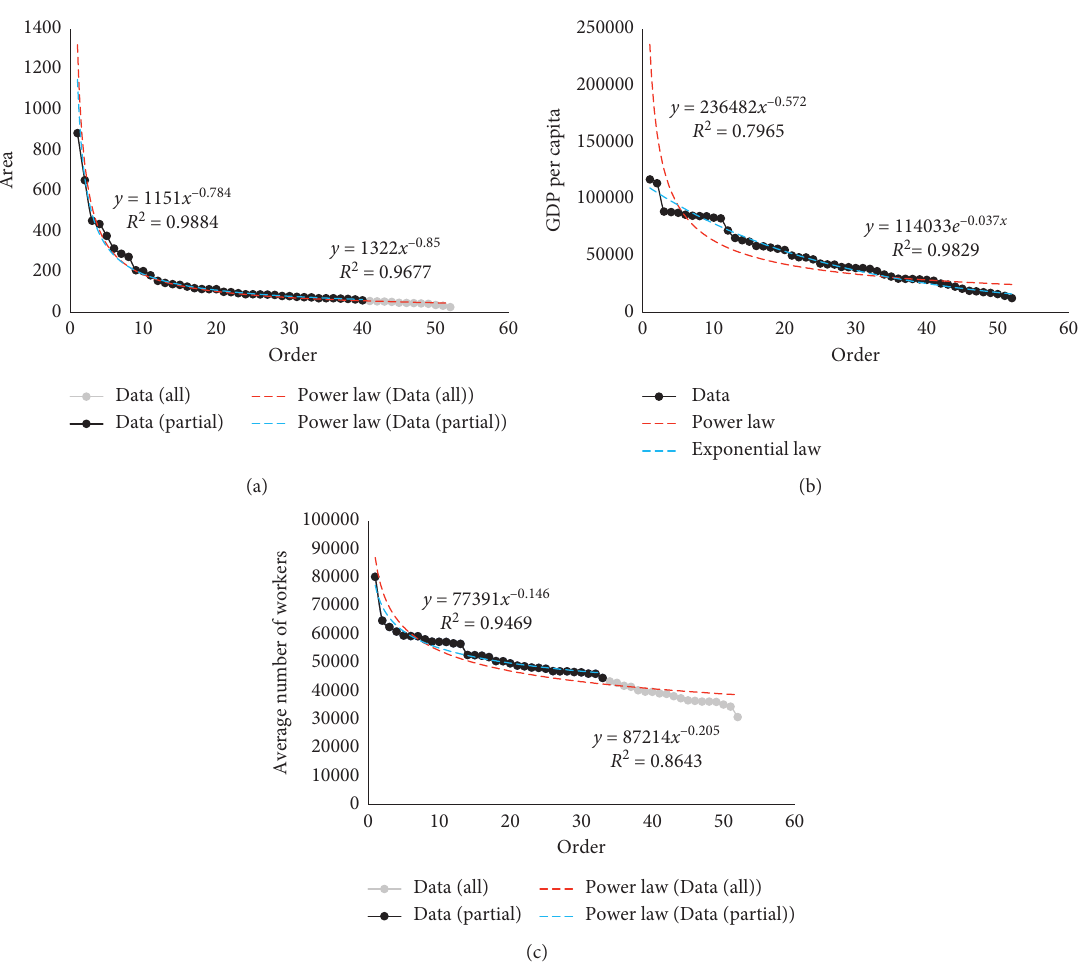
Figure 1: Function fitting of the Yangtze river’s lower reaches. (a) Built-up area. (b) GDP per capita. (c) Average salary in the municipal